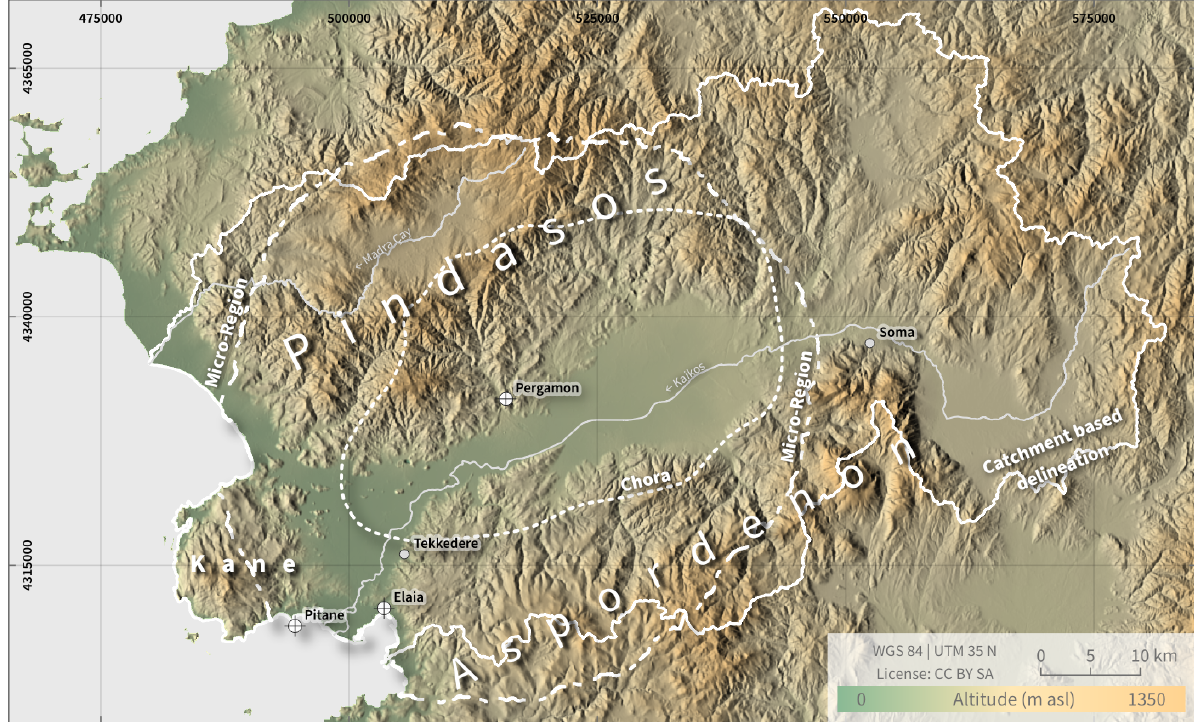
Figure 1. Map of the research area. White lines correspond to the different heuristics of the complementary region of Pergamon (Chora of Pergamon during Roman Imperial Period is based upon Sommerey [8]; the Pergamon Microregion is based upon a 16-h walking territory; Bakırçay and Madra catchment taken from Yang et al. [26]; elevation information is based upon TanDEM-X